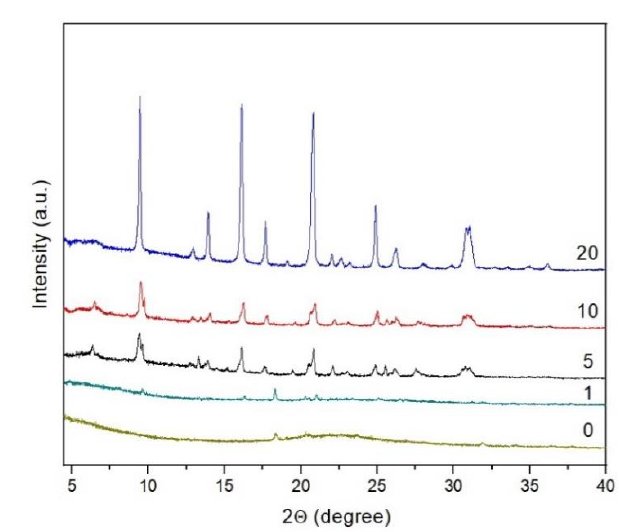
Figure 2. pXRD of as-made SSZ-13 products obtained from mixtures prepared with precipitated silica with an application of milling for various times: 0—only preliminary manual grinding, 1, 5, 10, 20 min of milling. (Reprinted with permission from [46]. Copyright: 2019, John Wiley and sons.).